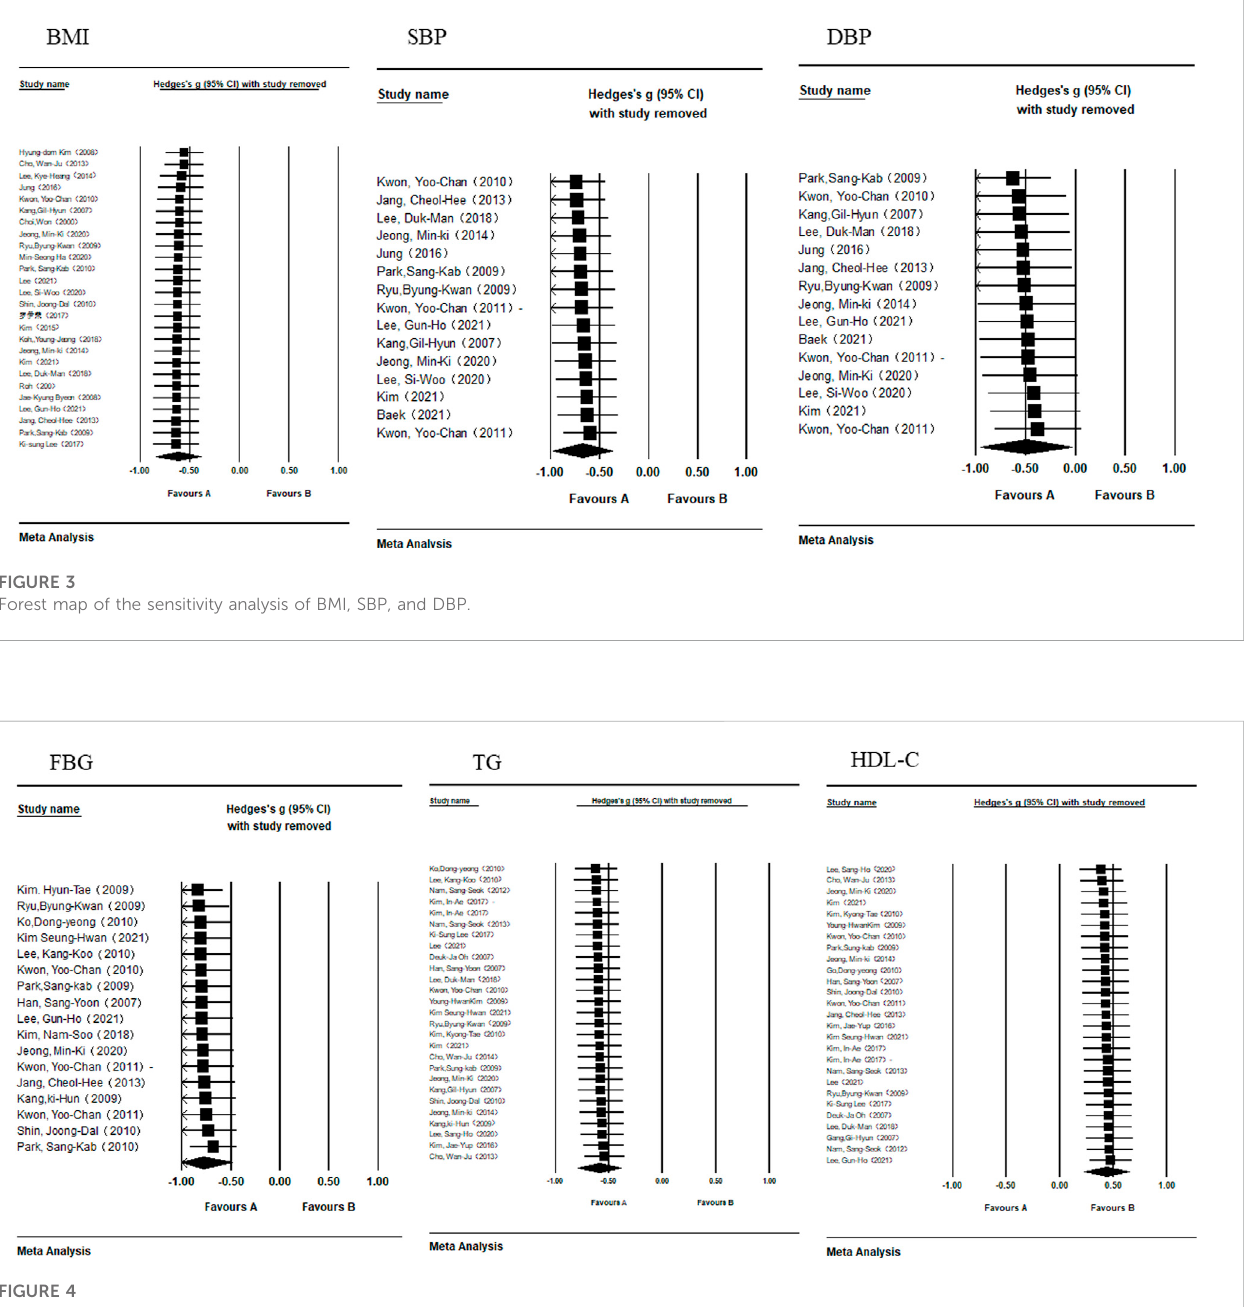
Forest map of the sensitivity analysis of FBG, TG, and